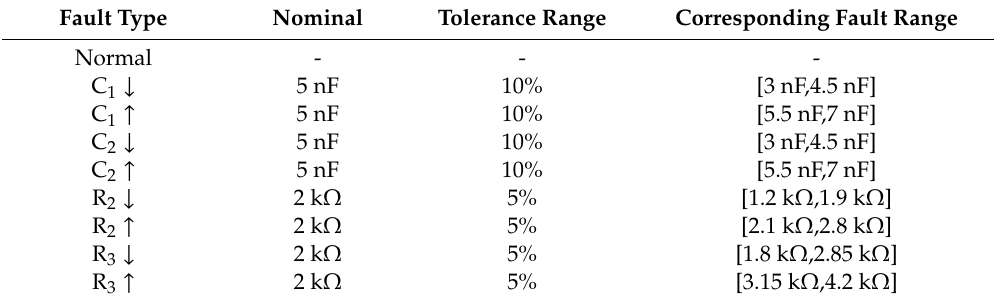
Table 4. Fault types of the Sallen–Key bandpass filter circuit.